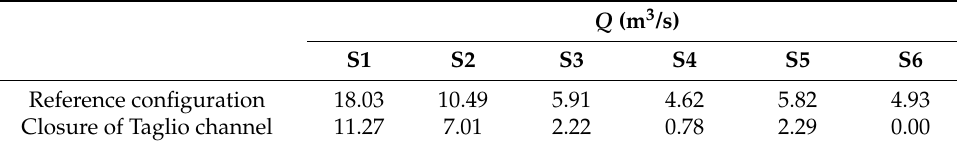
Table 3. Maximum discharge Q through selected cross sections resulting from the tidal simulation with no wind forcings, in the reference configuration and in the case of a complete closure of the Taglio channel.